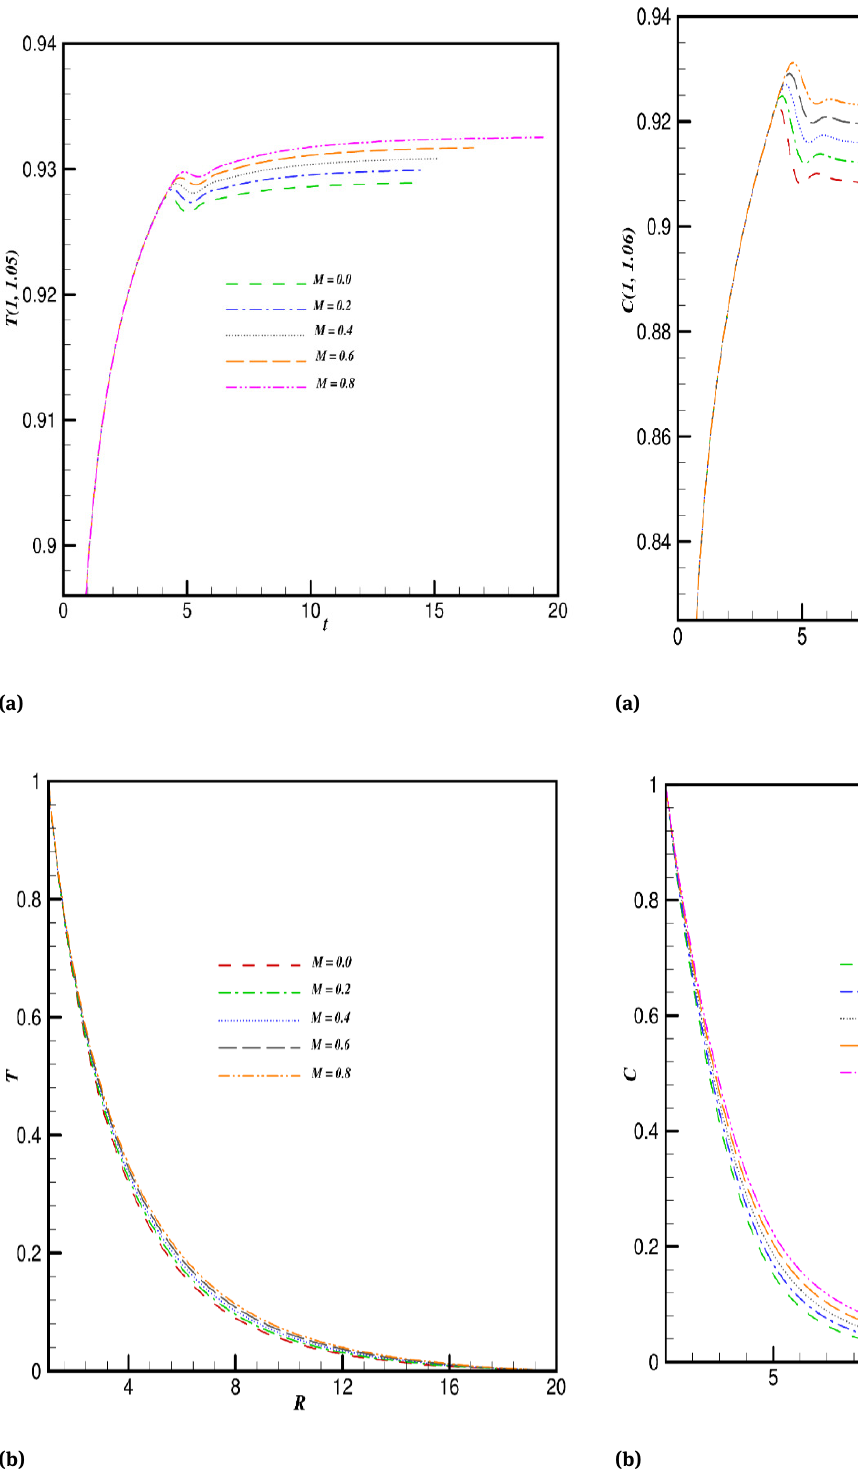
Figure 5: ( a ) Transient and ( b ) Steady state concentration profiles with fixed Sc = 0.6 , Pr = 0.7 , Bu = 1.0 , Kr = −0.2 , Nr = 2.0 , K 1 = 1.0 , Ec = 0.1